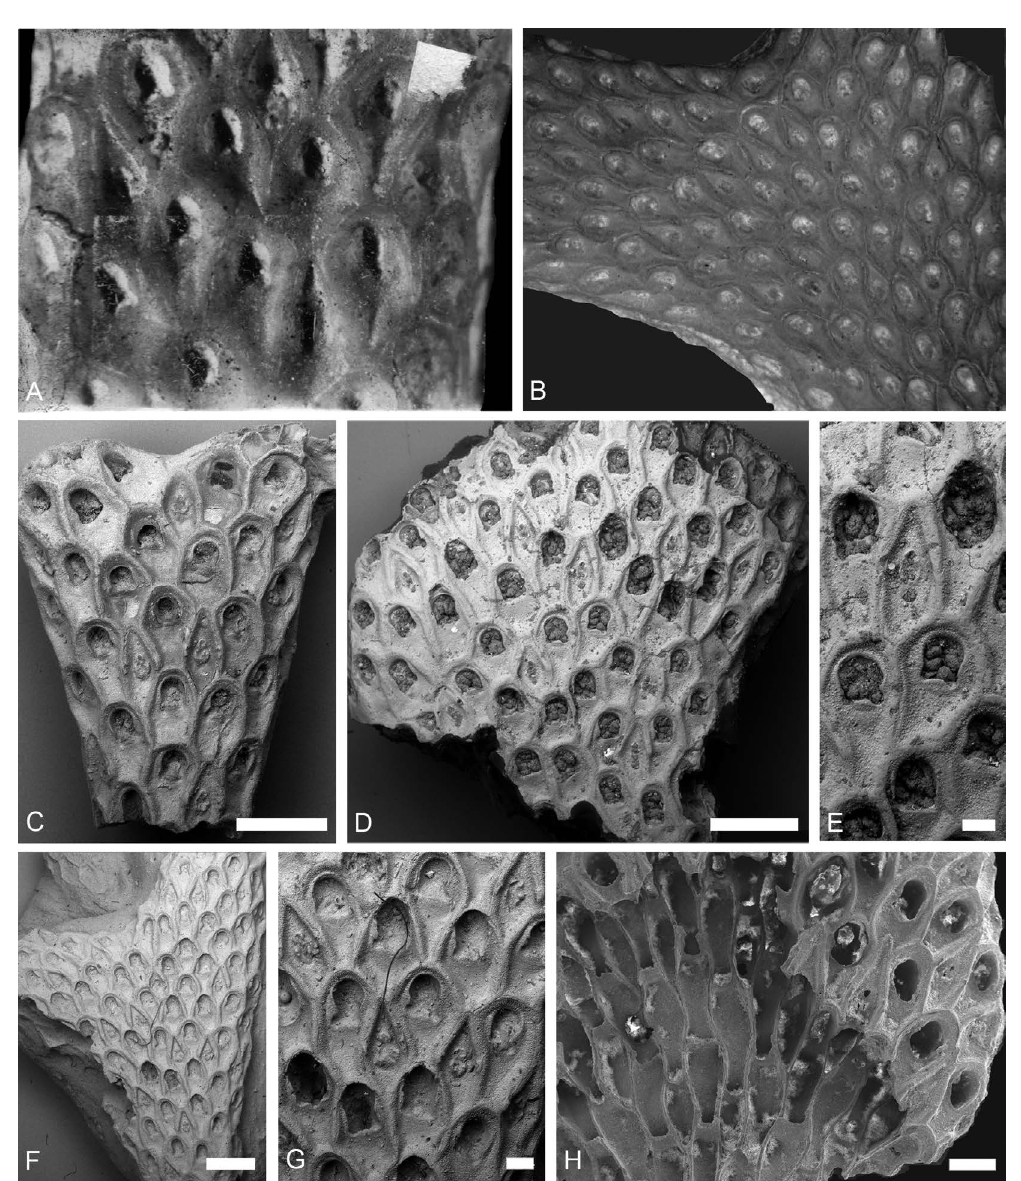
Fig. 16. Rhagasostoma rowei (Brydone, 1906). A–B . Late Cretaceous, Ulyanovsk Region, Russian Federation. A . PSM PSU 2/187, this specimen, which is the original figured by E. Eichwald (1868: pl. 8, fig. 9) as Eschara volgensis Eichwald, 1865, could not be traced but is represented by this photograph taken by E. Voigt in 1963; overview of part of erect bifoliate colony showing autozooids and avicularia. B . MMI 15/49, the specimen from Yazykov, which is the original figured by I.I. Lahusen (1873: pl. 4, fig. 4) as Eschara volgensis Eichwald, 1865; overview of erect bifoliate stem-like then dichotomously branching colony. C–G . Early Maastrichtian ( Ostrea lunata Zone), Trimingham, Norfolk, England, UK. C . Holotype, SM B36113, overview of erect bifoliate stem-like then dichotomously branching colony. D–E . Paratype, SM B36260. D . Overview of fan-like part of bifoliate colony. E . Autozooids and avicularia. F–G . SM B36697, specimen labelled as O. mimosa from the Brydone Collection. F . Overview of erect bifoliate stem-like then dichotomously branching colony. G . Non-ovicellate and two ovicellate (in the left lower corner) autozooids and avicularia. H . 2922/204, from an erratic block of ?late Campanian age in a quarry near Hrodna/Grodno (Гродна/Гродно), Grodno Region, Belarus, view of undersides of zooidal frontal walls. Scale bars: A–B without scale bars; C–D, F = 1 mm; E, G = 200 µm; H = 300